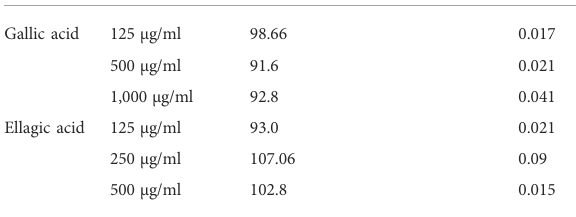
TABLE 3 Accuracy of gallic acid and ellagic acid.